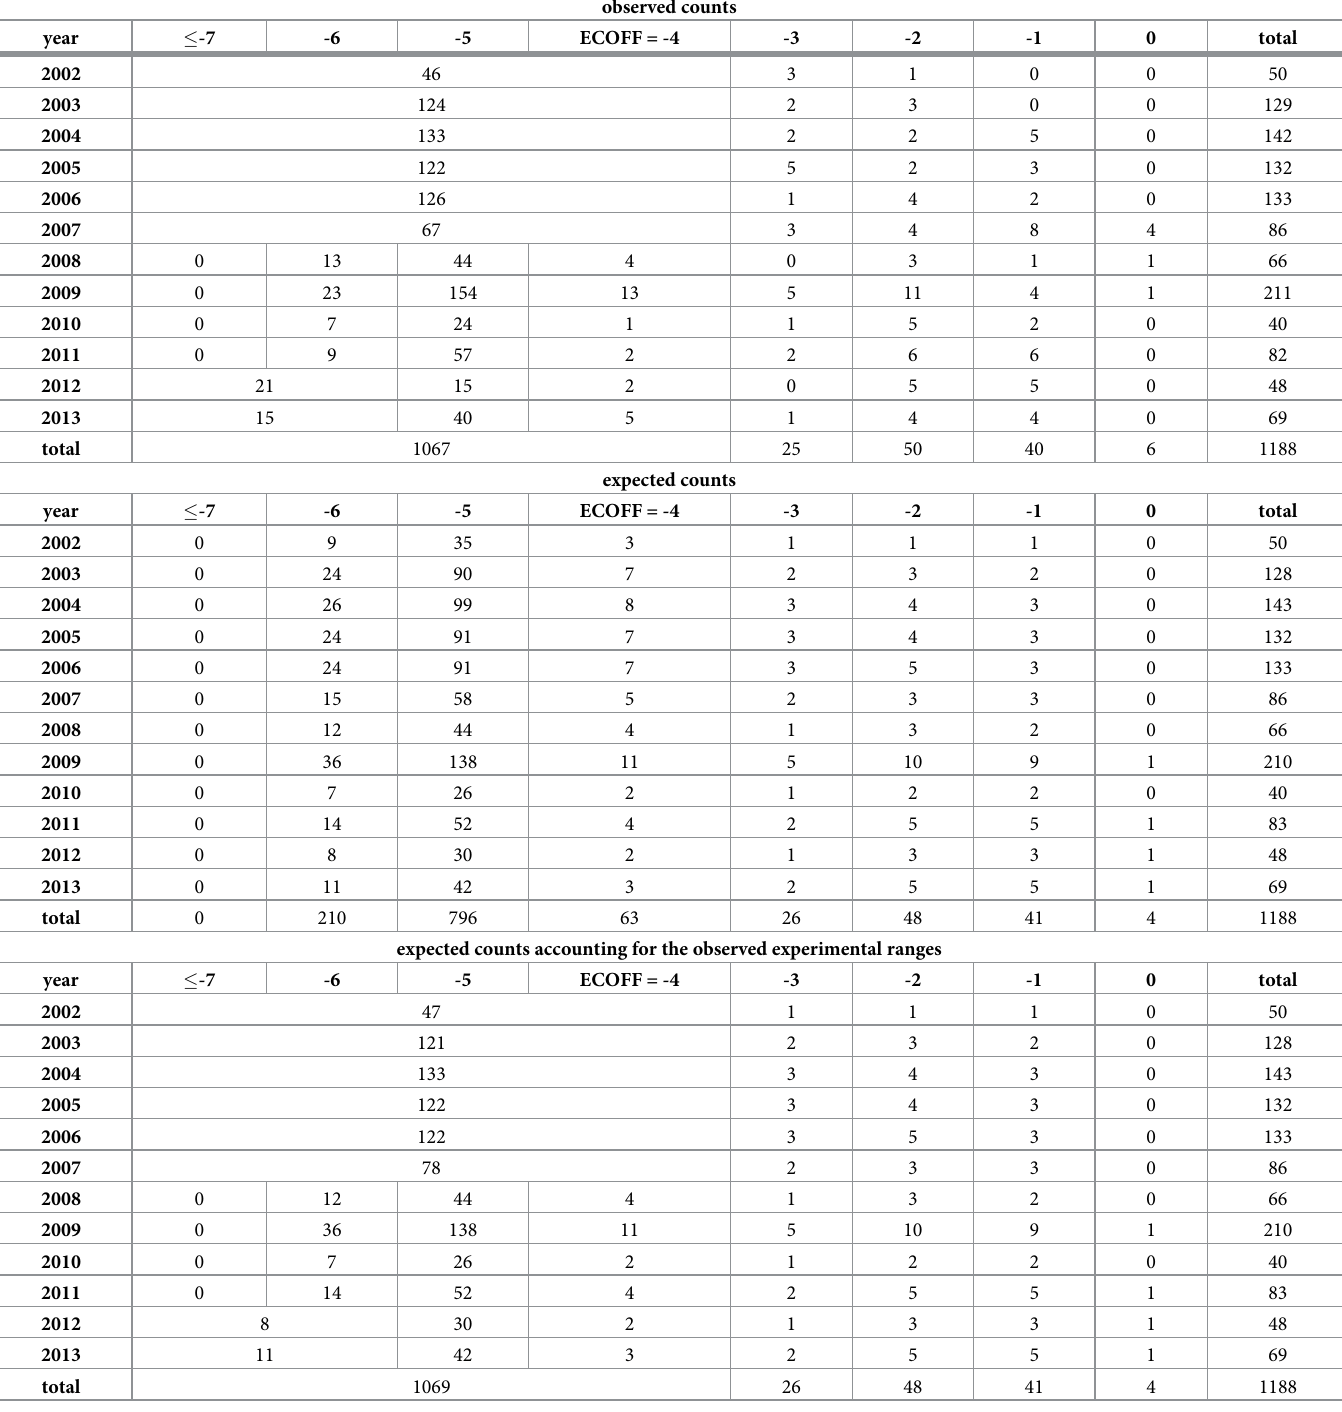
Table 5. The CIPR data. The upper table: observed counts for each year. Middle table: based on the best fitting model 7, the expected counts for each year. Lower table: based on the best fitting model 7, the expected counts for each year, according to the observed experimental